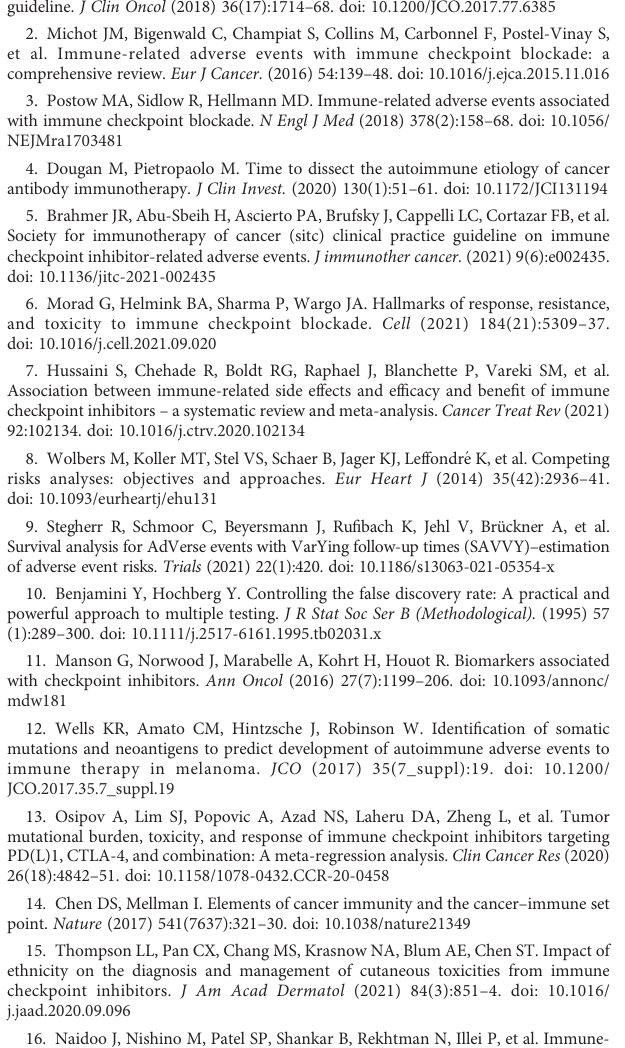
SUPPLEMENTARY TABLE 3 Confounder-adjusted results from the IPD meta-analysis to assess